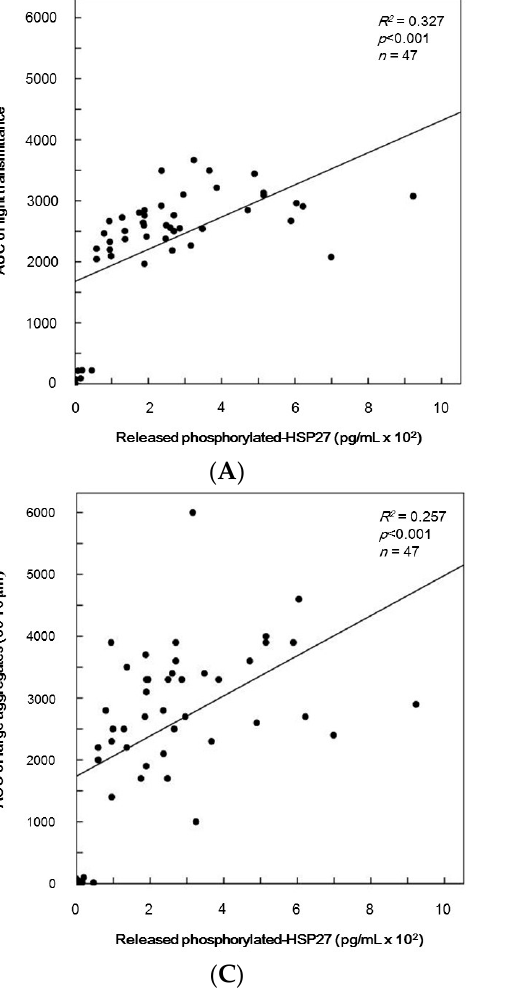
Figure 6. The relationship between individual levels of release of phosphorylated-HSP27 and the area under the curve (AUC) of platelet aggregation induced by TRAP in type 2 DM patients. The levels of release of phosphorylated-HSP27 in the supernatant of the conditioned plasma after platelet aggregation stimulated by 10 µM of TRAP for 4 min was determined using a specific ELISA kit. AUC of platelet aggregation stimulated by 10 µM of TRAP for 4 min were determined by an aggregometer (PA-200 apparatus, Kowa Co., Ltd., Tokyo, Japan) with laser-scattering system recorded individually by the size of aggregates, ( A ) AUC of total transmission; ( B ) AUC of medium aggregates; ( C ) AUC of large aggregates; ( D ) AUC of small aggregates. These data were plotted and then analyzed by linear regression analysis.